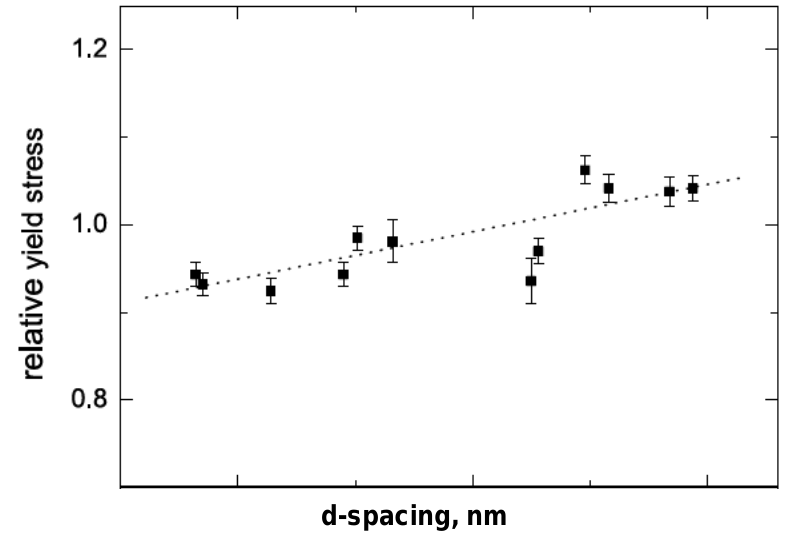
Figure 35. Relative yield stress as a function of the filler basal plane spacing used for the synthesis of polyethylene nanocomposites. Reproduced from reference [135] with permission from Elsevier.